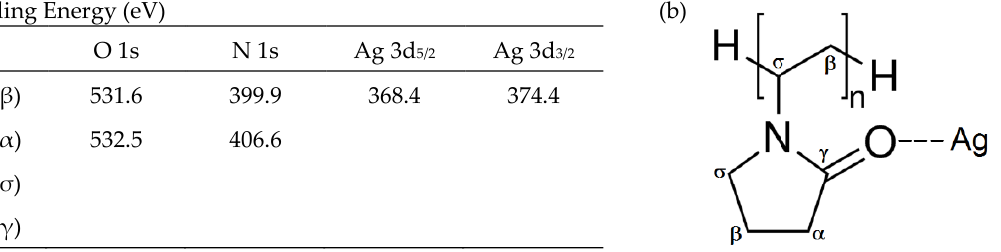
Figure 3. ( a ) Binding energy values for the PVP-stabilizing silver nanoparticle dispersion (AgNP), ( b ) Chemical structure of PVP and possible coordination with silver. Four peaks centered at 285.0, 285.4, 286.1, and 287.8 eV, typical of PVP, were fitted into the C 1s envelope. The detailed assignment is presented in Figure The O 1s region (Figure 2b) was fitted with two peaks: one centered at 531.6 eV,